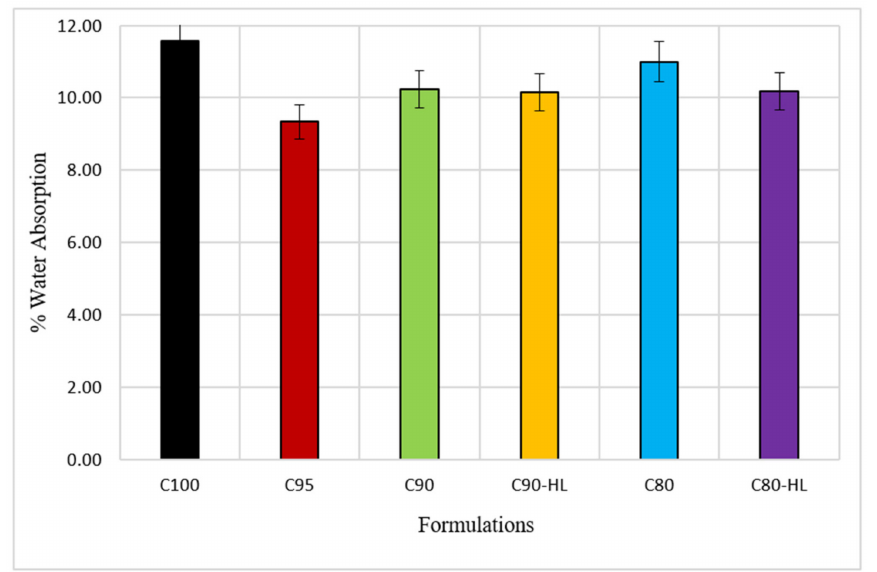
Figure 14. Effect of waste burnt brick powder on water absorption of self-compacting paste